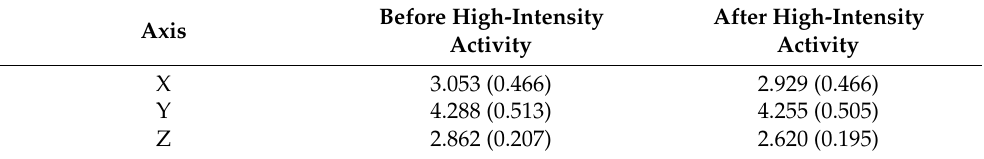
Table 2. Static relative error (%) for each accelerometer axis before and after high-intensity activity. Axis